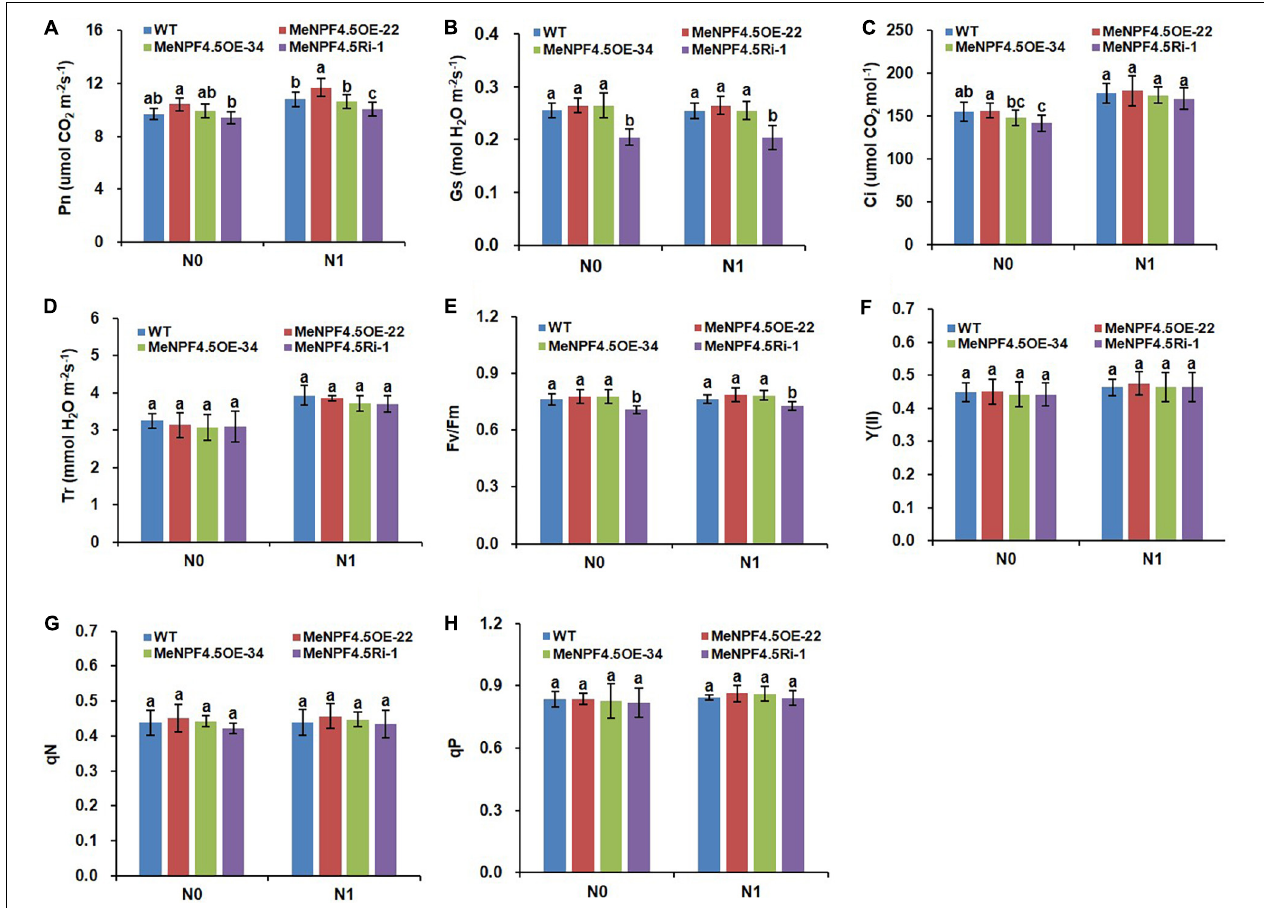
FIGURE 6 | Photosynthetic and chlorophyll fluorescence parameters of WT and MeNPF4.5 transgenic cassava plants. (A) Photosynthetic rate (Pn). (B) Stomatal conductance (Gs). (C) Intercellular CO 2 concentration (Ci). (D) Transpiration rate (Tr). (E) Fv/Fm. (F) Y(II). (G) qN. (H) qP. Values are the means of five biological replicates ± SE. Lowercase letters above the bars (a-d) represent significant differences between treatments as determined by Student’s t -test ( P < 0.05). N0, low-N treatment, 0 kg ha − 1 ; N1, normal N treatment, 125 kg ha − 1